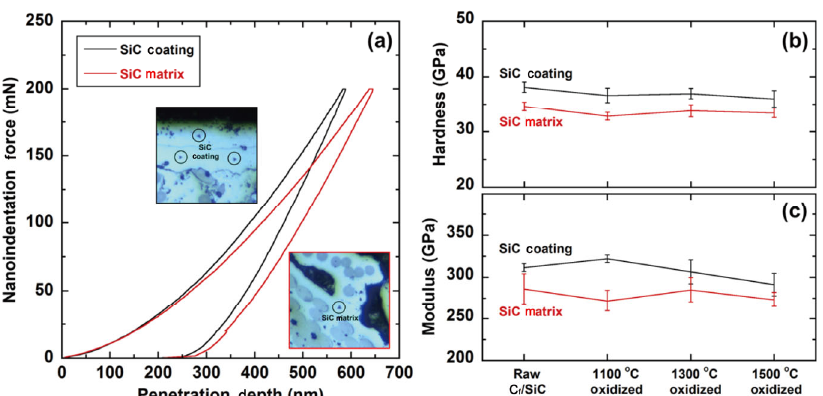
Fig. 11 (a) Representative force–displacement curves of SiC coatings and SiC matrix by nanoindentation; (b, c) hardness and Young’s modulus vs. oxidation temperature, respectively.